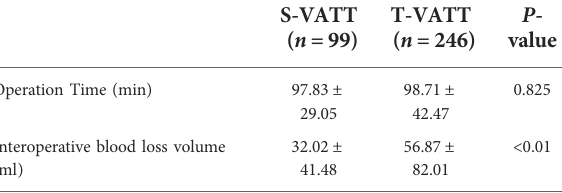
TABLE 3 Comparison of intraoperative indicators between the two groups.